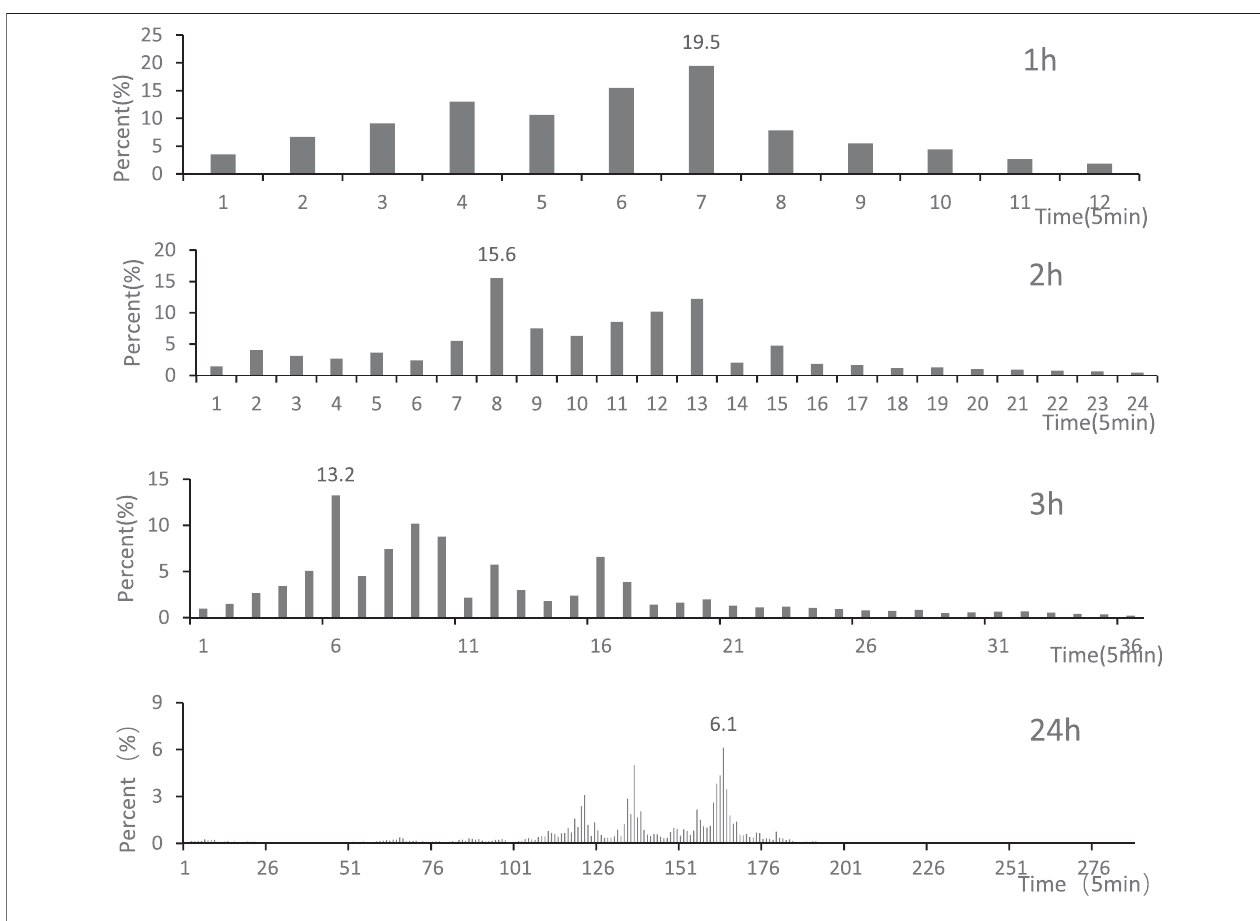
FIGURE 2 | The rainstorm hyetograph design of four durations obtained with the P&C method.